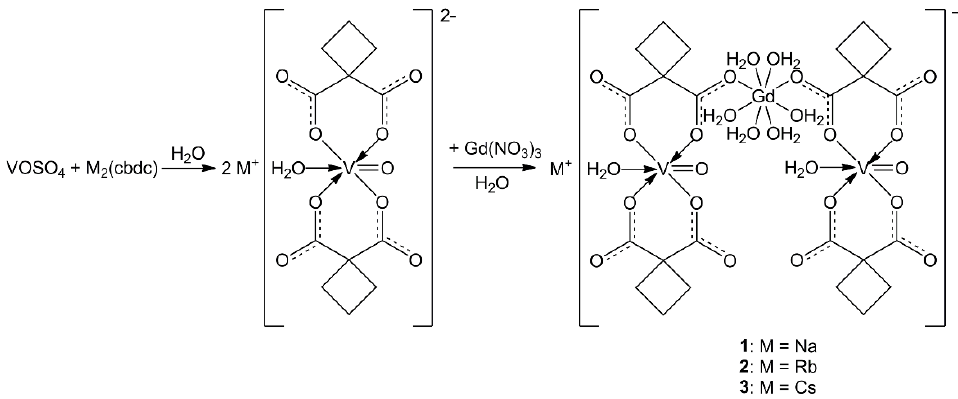
Scheme 1. Scheme illustrating the formation of compounds 1 – 3